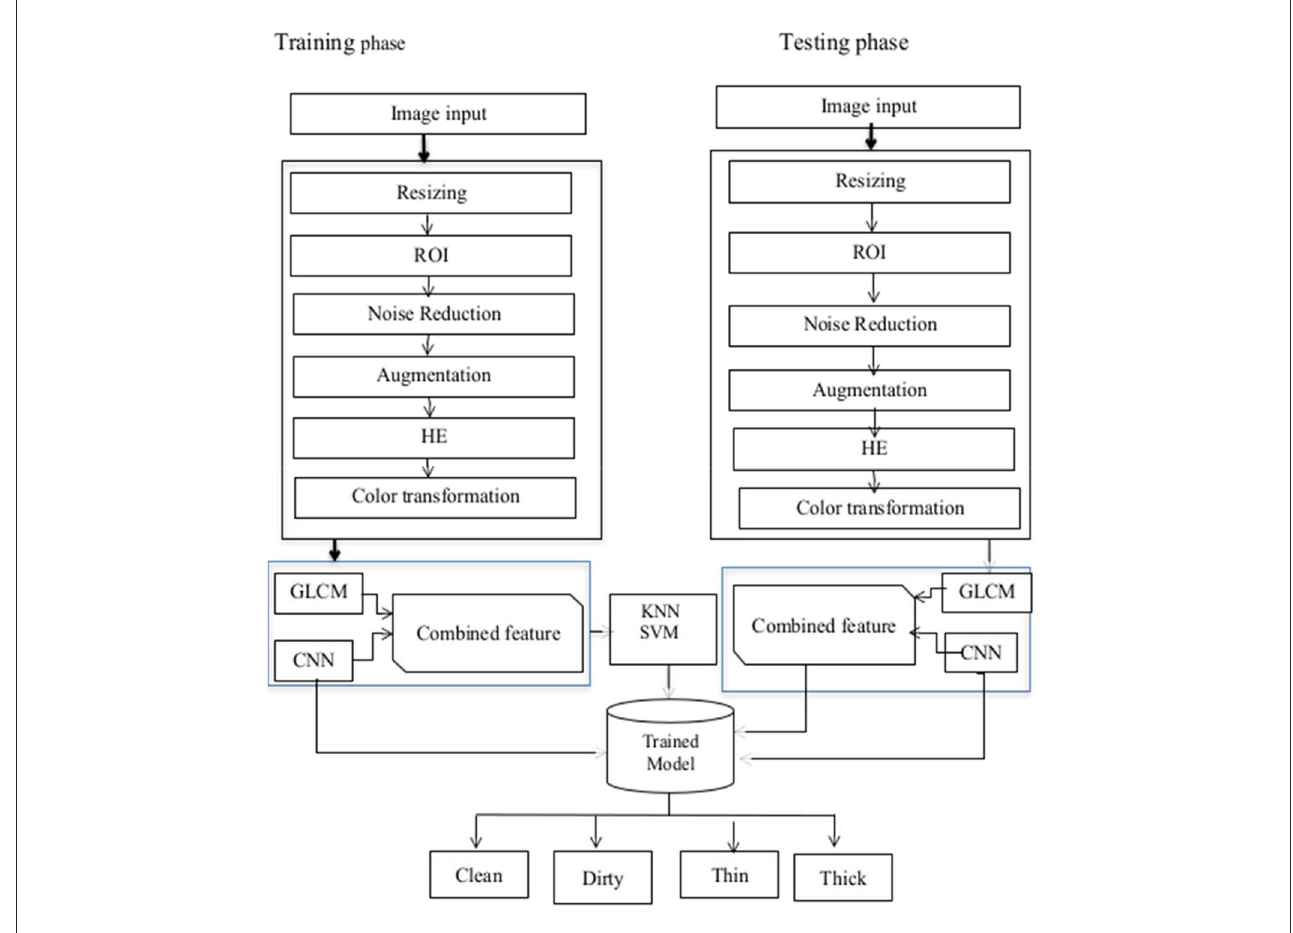
FIGURE1 Proposed model